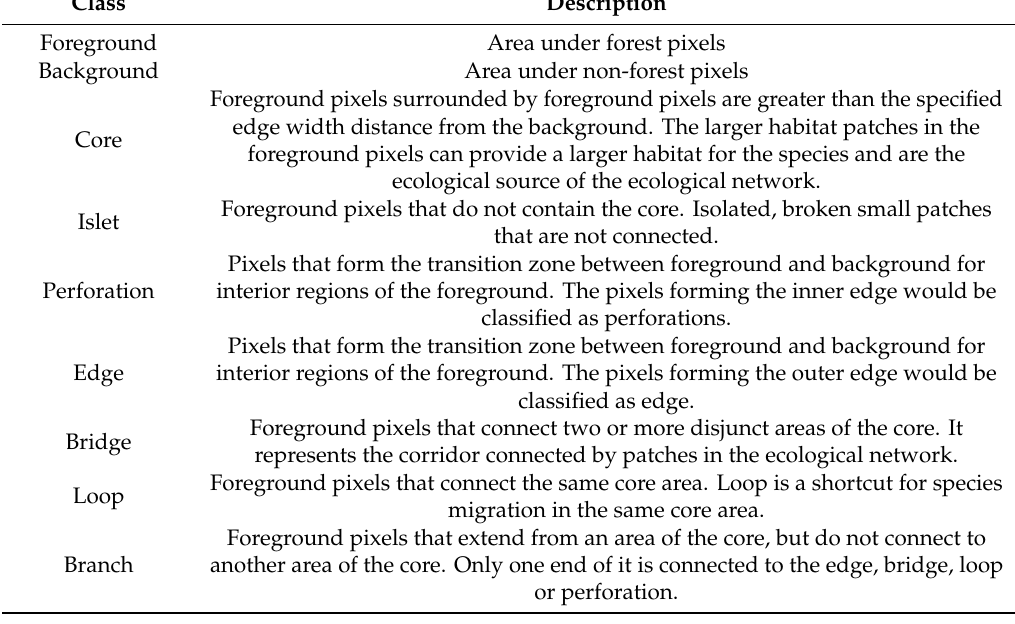
Table 1. Definition of landscape type based on the morphological spatial pattern analysis